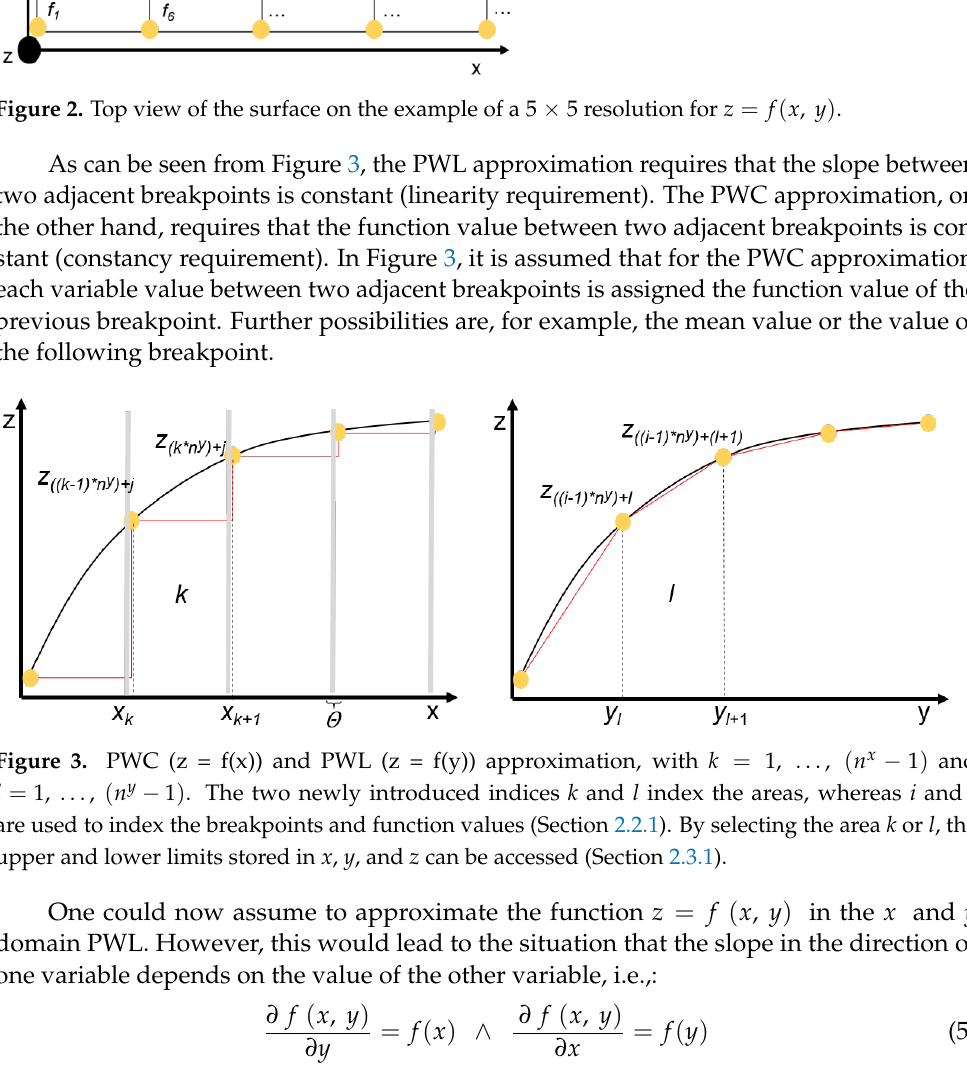
Figure 2. Top view of the surface on the example of a 5 × 5 resolution for z = f ( x , y ) .